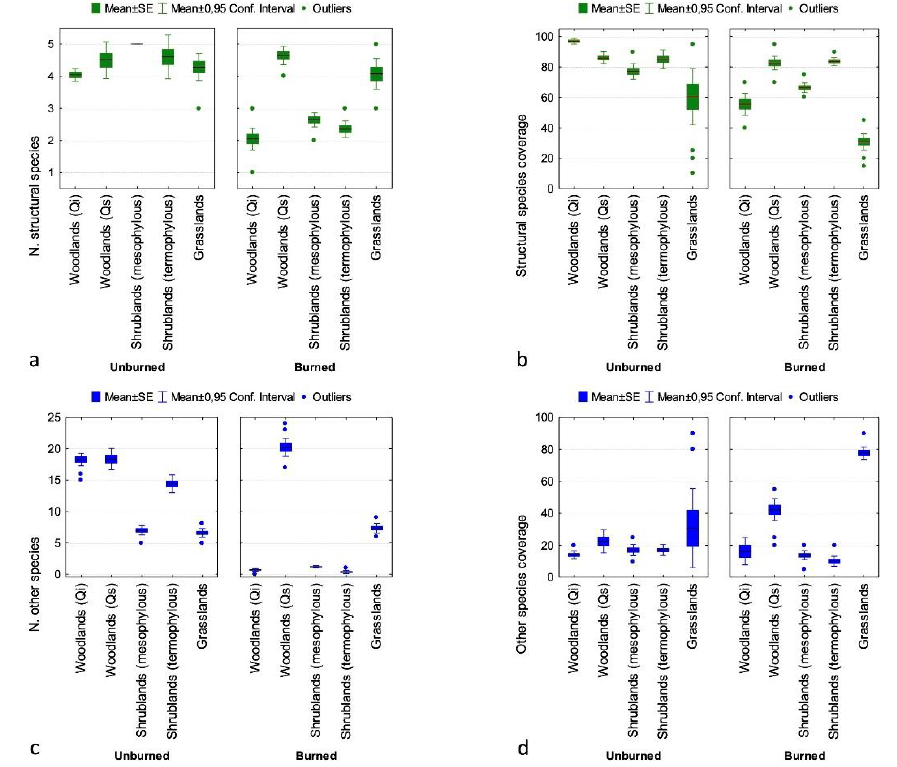
Figure 10. Comparison between number ( a ) and coverage ( b ) of structural plant species and number ( c ) and coverage ( d ) of other plant species in the different types of burned and unburned vegetation.